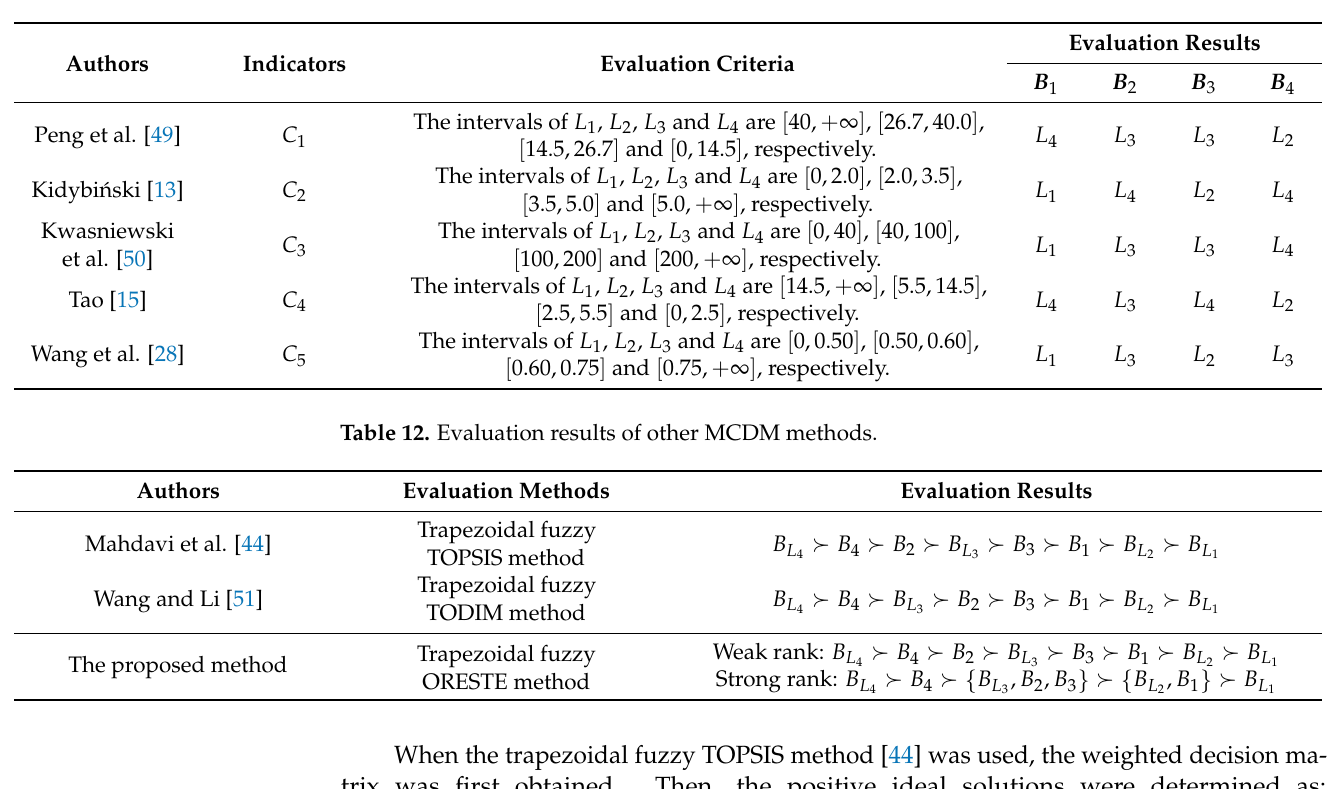
Table 11. Evaluation results of empirical methods.